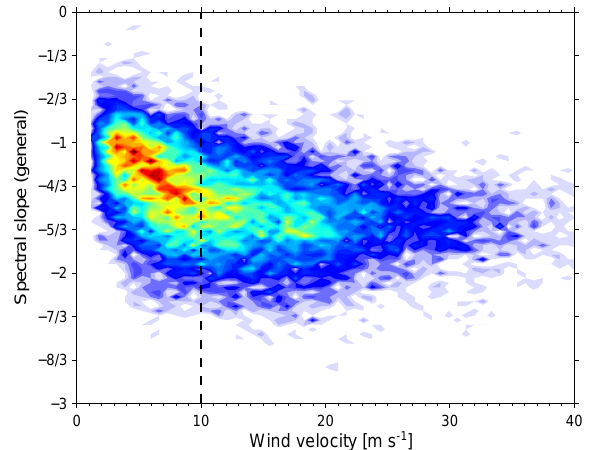
Figure 8. Dependence of the general spectral slope of vertical wind velocity on the background wind fields. The black dashed line indi- cates the horizontal wind = 10ms − 1